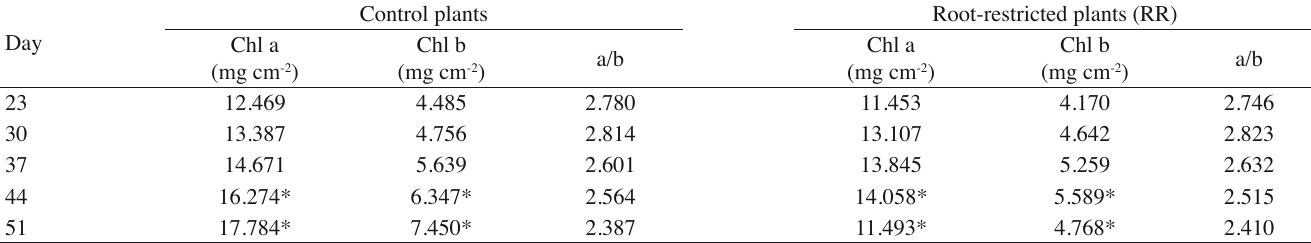
Table 1 - Chlorophyll content ( a , b and a / b ratio) measured at weekly intervals from day 22 to the end of the experiment in leaves collected from control and root-restricted (RR) plants